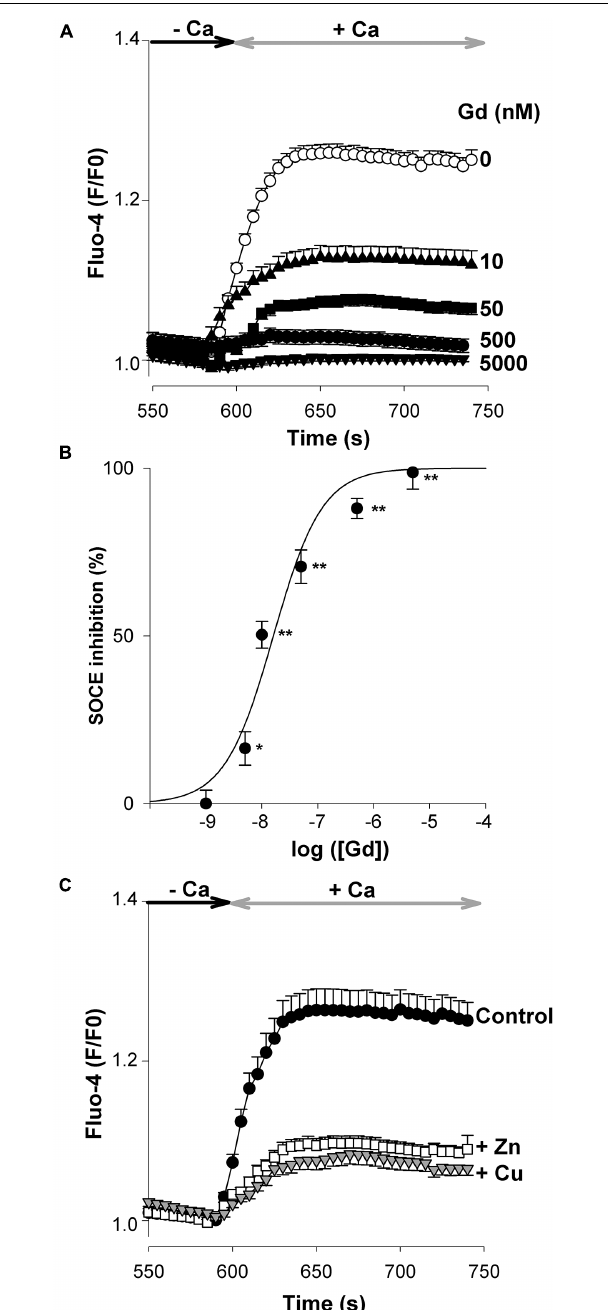
FIGURE 4 | Inhibition of SOCE by the external cations, Gd 3 + , Zn 2 + , and Cu + / 2 + . The protocol used is the same as in Figure 2 . (A) The Tg-evoked entry of Ca 2 + was recorded in the absence (open circles, n = 102 cells) or presence of various concentrations of GdCl 3 (filled symbols; 10 nM n = 144 cells; 50 nM n = 132 cells; 500 nM n = 112 cells; 5000 nM n = 67 cells). (B) dose-response curve showing the inhibition (%) of the peak amplitude of the SOCE as a function of the external concentration of GdCl 3 . ∗ and ∗∗ , p < 0.05 and p < 0.01, respectively. (C) Inhibitory effect of 10 µ M ZnCl 2 (open squares, n = 129 cells) and 10 µ M CuCl 2 (gray triangles, n = 115 cells) on SOCE. Filled circles: untreated (control) cells ( n = 101 cells). The graphs (A,C) show the last 200 s of the recording. Mean ± SEM.